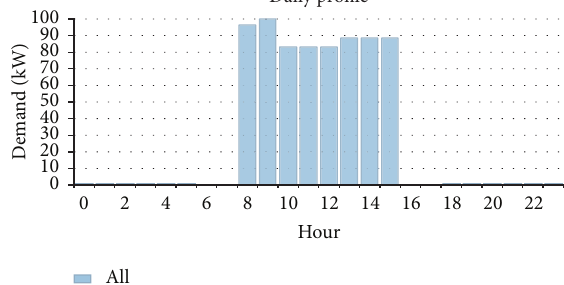
Figure 1: Station average daily load variation, Ikorodu, Lagos [7].